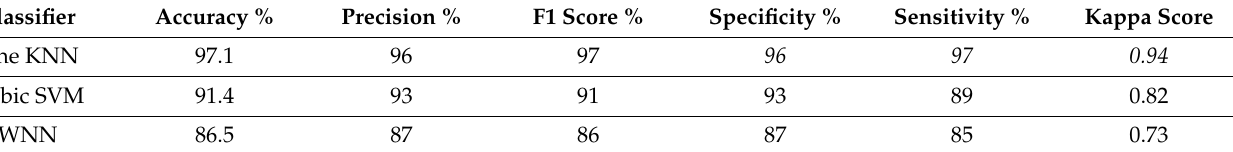
Table 4. Results of classification on MURA elbow fracture dataset using ten-fold validation.